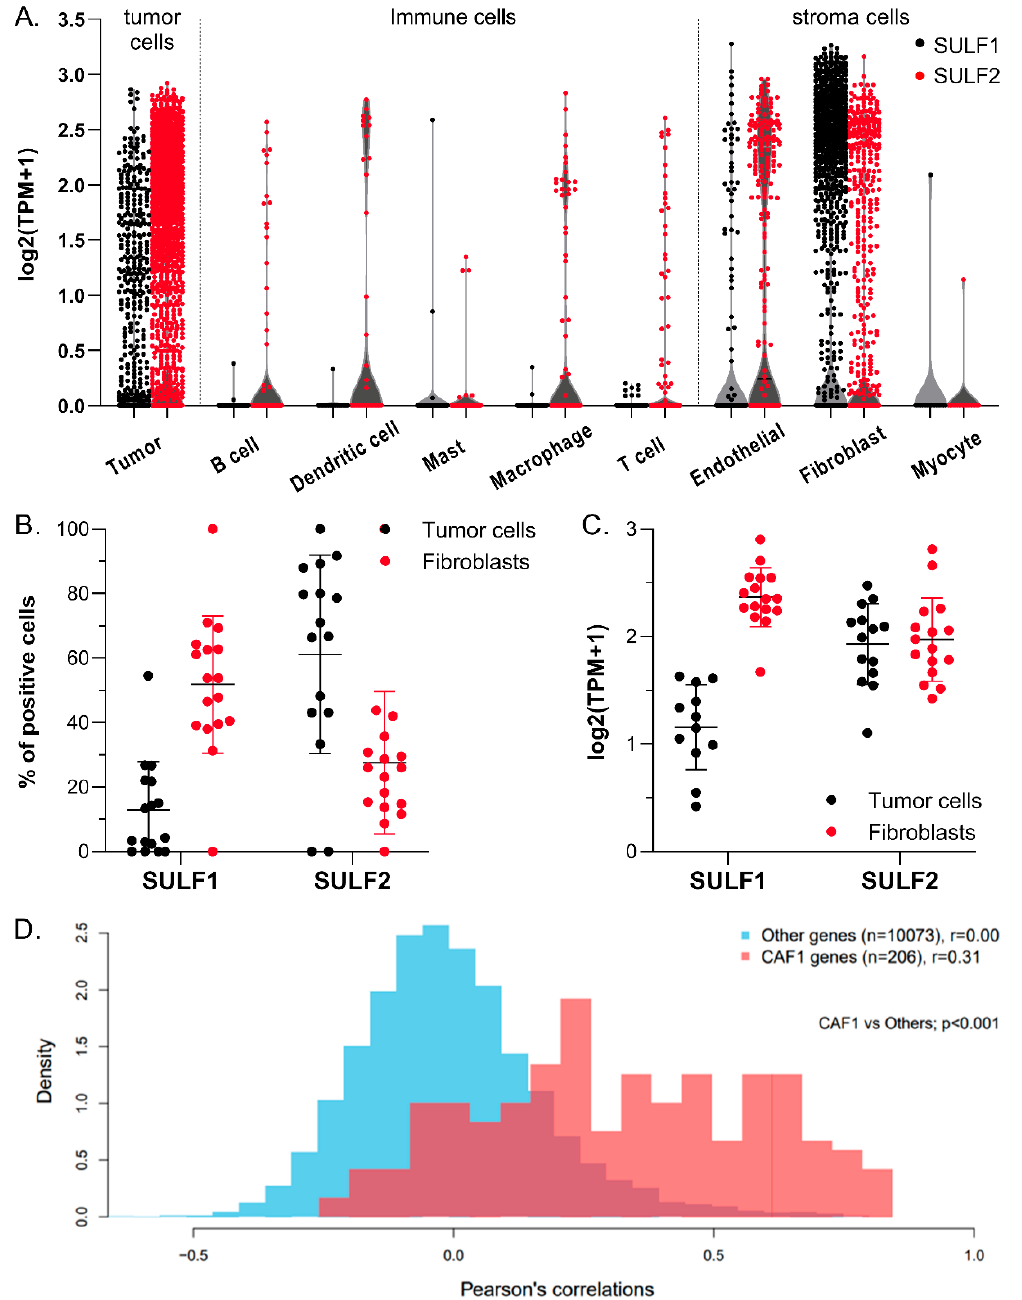
Figure 4. SULF1 and SULF2 are differentially expressed in HNSC epithelial and fibroblast cells. ( A ) SULF1 and SULF2 mRNA expression in different cell types detected in HNSC tumors; ( B ) percent of cells expressing SULF1 or SULF2 differ between the tumor epithelial and fibroblast cells ( p < 0.0001, two-way ANOVA); ( C ) expression of SULF1 mRNA in SULF-positive cells differs between tumor epithelial cells and fibroblast ( p < 0.001) but SULF2 does not ( p = 0.800); and ( D ) distribution of Pearson’s correlation coefficients of SULF1 with CAF1 (n = 206) and other (n = 10,073) proteins measured in the CPTAC HNSC study [28]. Correlation coefficients of SULF1 protein (red bars) with the CAF1 proteins are significantly ( p < 0.001) higher than the correlations with other proteins. Analyses and the definition of CAF1 are based on a single-cell RNA-seq study of 5578 cells in tumor tissues of 18 HNSC patients [27].